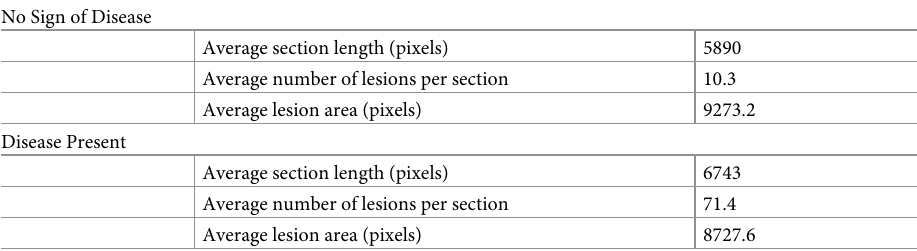
Table 3. Keratin 5 expression in post-vismodegib excision